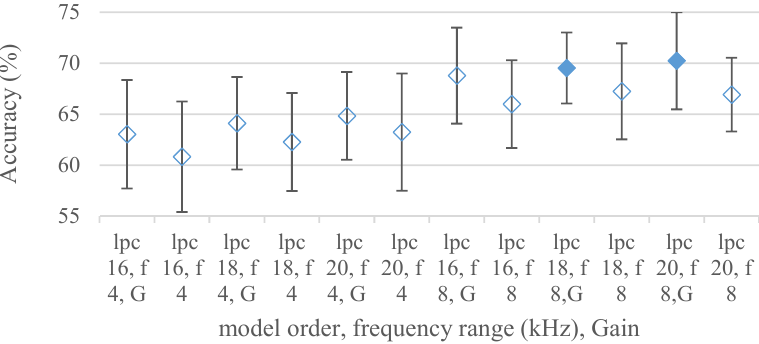
Figure 14. Averaged accuracies and standard deviations for LPC model orders (lpc) ranging from 8 to 18, for 4 and 8 kHz maximal frequencies (f), and pre-emphasis. Filled marks show equally performing settings.